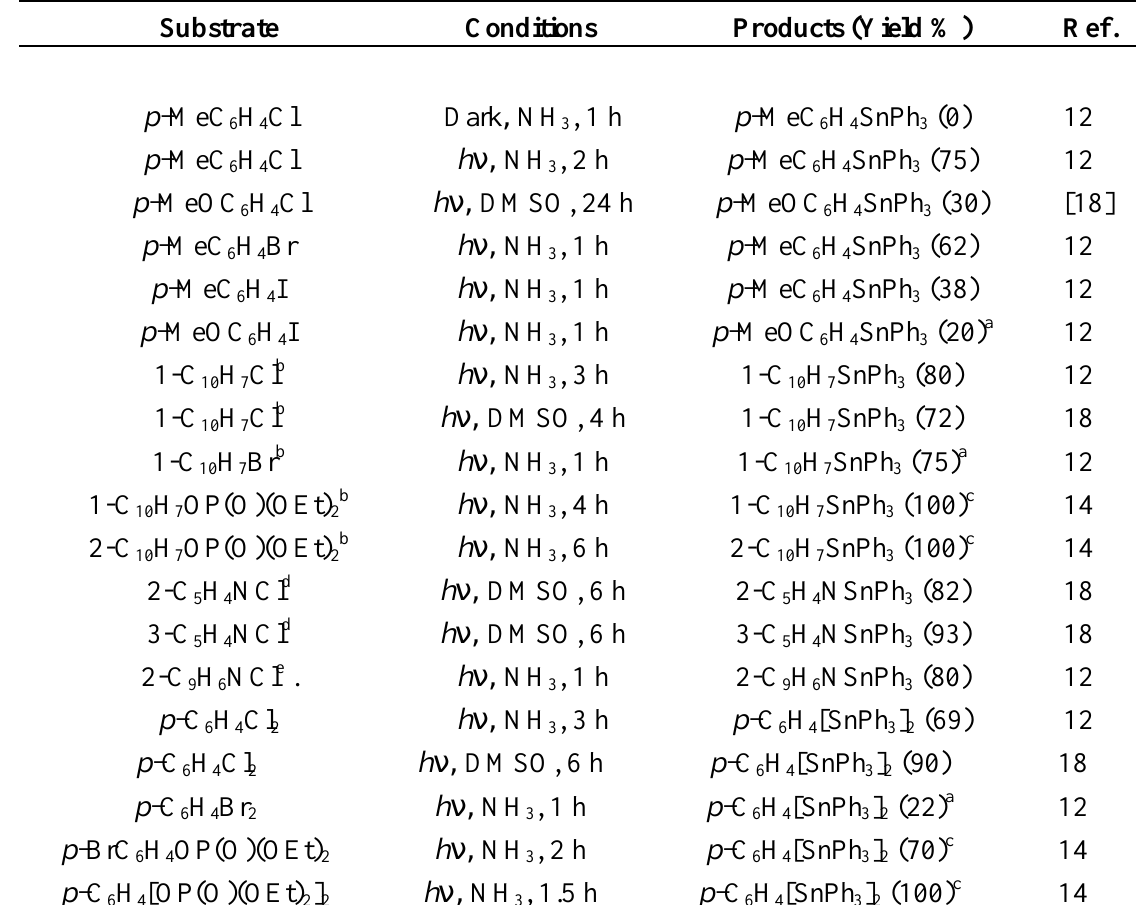
Sn - ions with aromatic compounds by the S 3